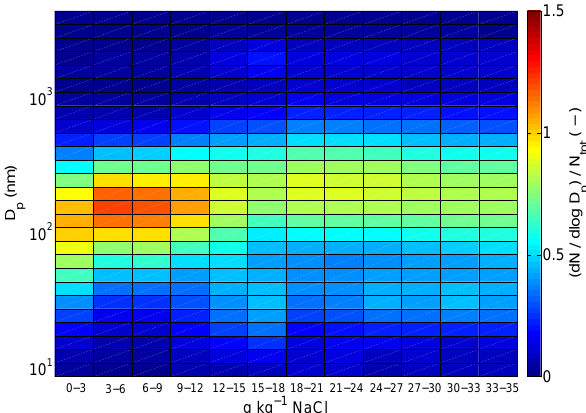
Fig. 6. Normalized fitted particle number size distributions for dif- ferent salinity ranges. RH mean = 43% for salinities between 0 and 18gkg − 1 ; RH mean = 24% for salinities between 18 and 35gkg − 1 .